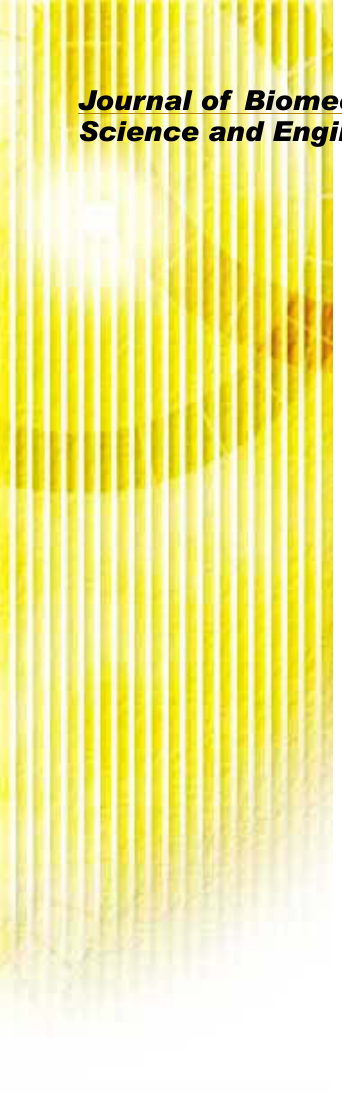
orthogonal array and experimental drills used in the drilling tests 9